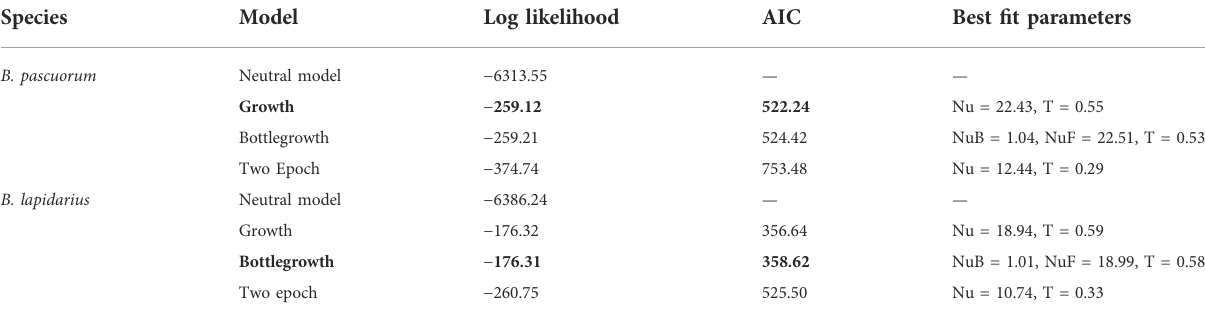
TABLE 4 Demographic model Log Likelihood (LL) and Akaike Information Criterion (AIC) generated by dadi . The best- fi tting model for each species hasbeenhighlightedinbold.Forallmodels,theparameterTreferstothetimeatwhichchangebegan,inunitsof1.5N a (ancestralpopulationsize) generations.Nureferstotheratioofmoderntoancientpopulationsize;NuBistheratioofthebottleneckpopulationsizetoancientpopulationsize; NuF is also the ratio of modern to ancient population size.